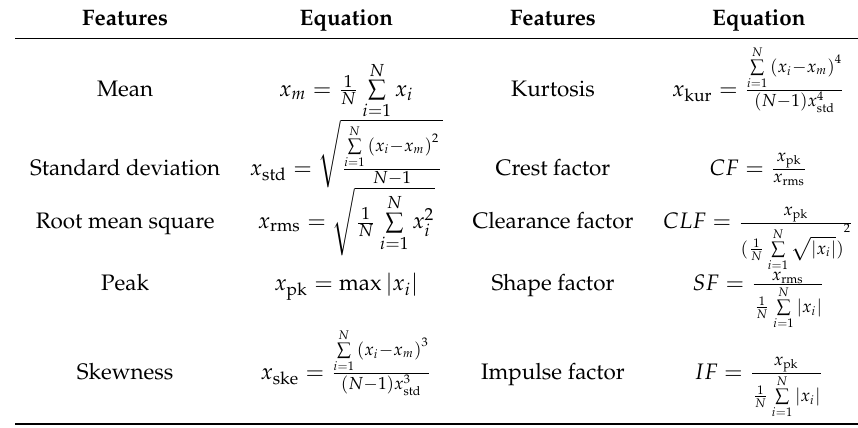
Figure 6. Sample normalized simultaneous-fault patterns of WTGS. ( a ) Gear tooth broken and chipped tooth; ( b ) chipped tooth and wear of outer race of bearing; ( c ) gear tooth broken and wear of cage and rolling elements of bearing; ( d ) gear tooth broken and wear of cage and rolling elements of bearing and wear of outer race of bearing. Table 4. Definition of the selected statistical features for acoustic signal. (Note: x i represents a signal series for i = 1,... N . where N is the number of data points of a raw